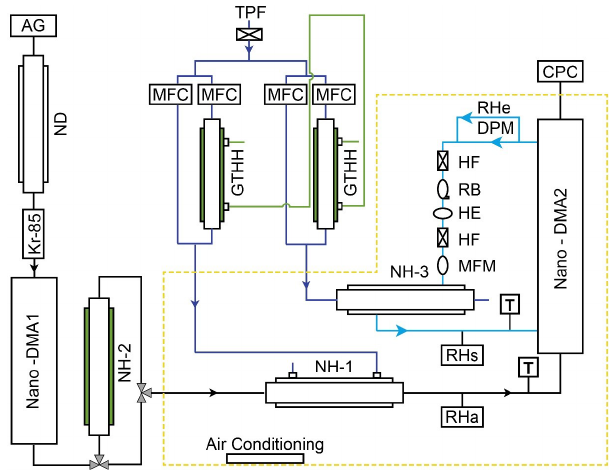
Figure 1. Experimental setup of the nano-HTDMA. AG: aerosol generator (aerosol atomizer or electrospray); ND: Nafion dryer; Kr-85: krypton source aerosol neutralizer; Nano-DMA: nano- differential mobility analyzer; TPF: total particle filter; HF: hy- drophobic filter; MFC: mass flow controller; MFM: mass flow me- ter; RB: recirculation blower; DPM: dew point mirror; GTHH: Gore-Tex humidifier and heater; NH: Nafion humidifier; HE: heat exchanger; CPC: condensation particle counter. Black line: aerosol line; blue line: sheath line; royal blue line: humidified air; green line: Milli-Q water (resistivity of 18.2M (cid:127) cm at 298.15K). RH a and RH s (measured by RH sensors) represent the RH of aerosol and sheath flow in the inlet of nano-DMA2, respectively. RH e (mea- sured by dew point) represents the RH of excess air. T represents the temperature of aerosol and sheath flow in the inlet of